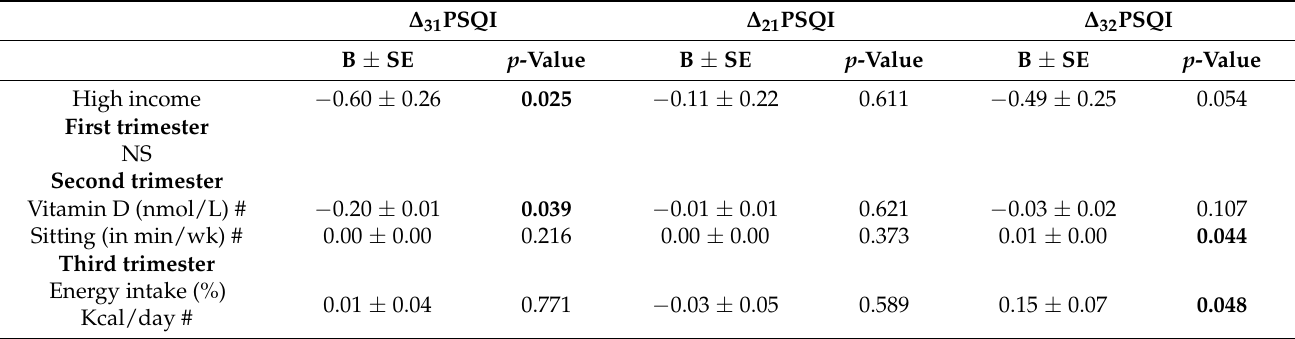
Table 5. Predictors of poor sleep (total PSQI) changes during pregnancy.